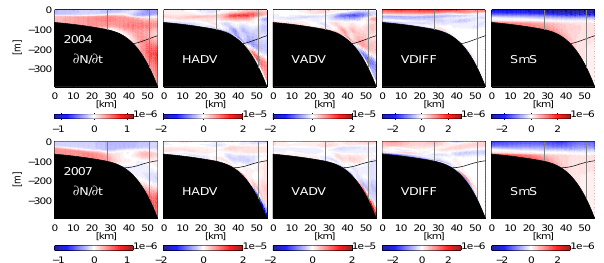
Figure 13. Term-by-term diagnostic analysis of nutrient equation. Shown from left to right are the local rate of change ( ∂ N/ ∂ t), horizontal advection (HADV), vertical advection (VADV), vertical diffusion (VDIFF), and biological source/sink (SmS) terms averaged over the early spring season (February-March-April) in year 2004 (top panels) and 2007 (bottom panels). The unit for all these terms is (mmol N)/(m3·s).The 34.5 isohaline, which is commonly used to define the location of shelfbreak front (Linder and Gawarkiewicz, 1998; Chen and He, 2010), is also shown in each figure as black curve to indicate the position of the shelfbreak front. Two gray vertical lines indicate the locations of 100 and 300m isobaths, between which the shelfbreak jet net nutrient budget terms are computed.